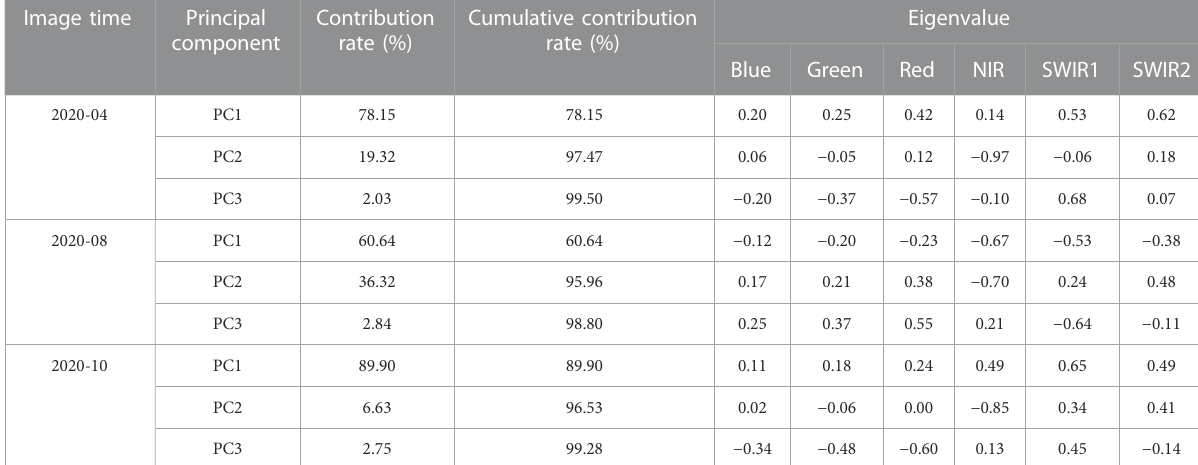
TABLE 2 Principal component analysis of the top three principal components in 2020. Image time